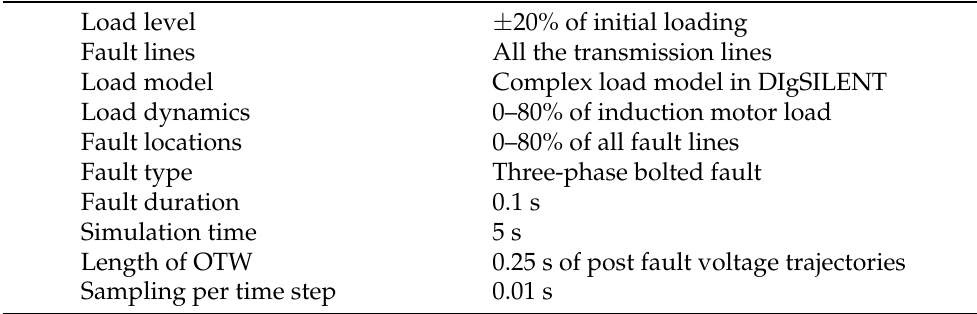
Table 3. Configuration of data set generation on test